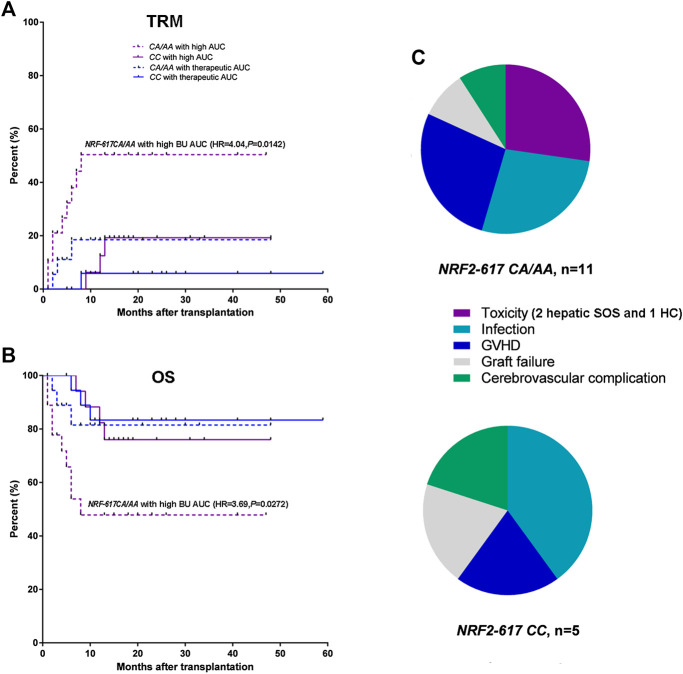

NRF2 -617 CA/AA genotypes predicted high TRM and poor OS in adult patients with above therapeutic AUC (n = 75). (A) Kaplan-Meyer curves of TRM and (B) OS according to BU AUC and NRF2 -617C/A genotypes. Blue and red lines represent the mortality or survival curves for the patients with therapeutic AUC (n = 40) and with high AUC (n = 35). Solid and dotted lines represent the curves for the patients with wild type (CC) and with heterozygous or homozygous genotype (CA/AA). (AA/CA in the patients with therapeutic AUC, n = 19; CC in the patients with therapeutic AUC, n = 21; AA/CA in the patients with high AUC, n = 19; CC in the patients with high AUC, n = 16) (C) Pie-chart representation of TRM causes of death in the patients with NRF2 -617CA/AA (n = 11) and NRF2 -617CC (n = 5). The toxicities were hepatic SOS (2 patients) and hemorrhagic cystitis (1 patients).